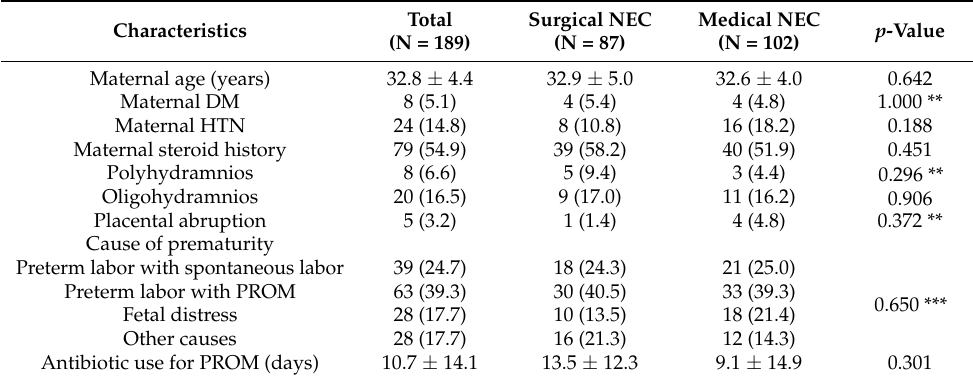
Table 2. Maternal factors.